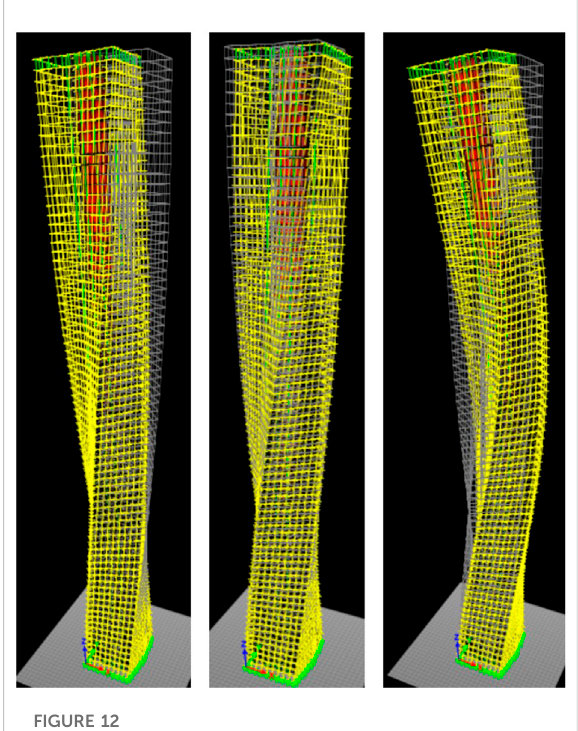
FIGURE 12 Eigen-value modal analysis (critical mode of